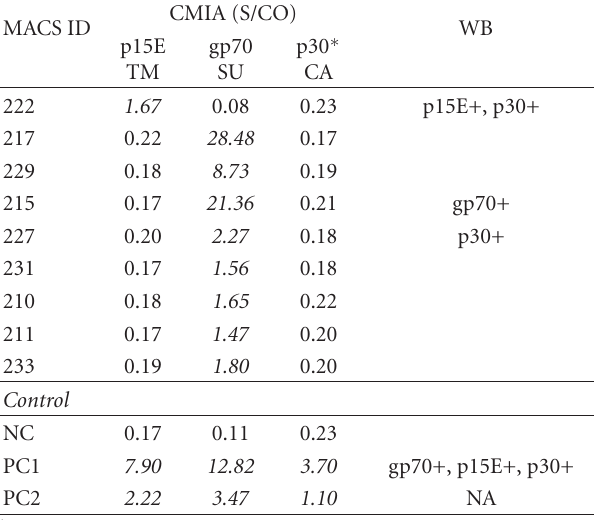
Table 1: XMRV antibody reactivity for the MACS